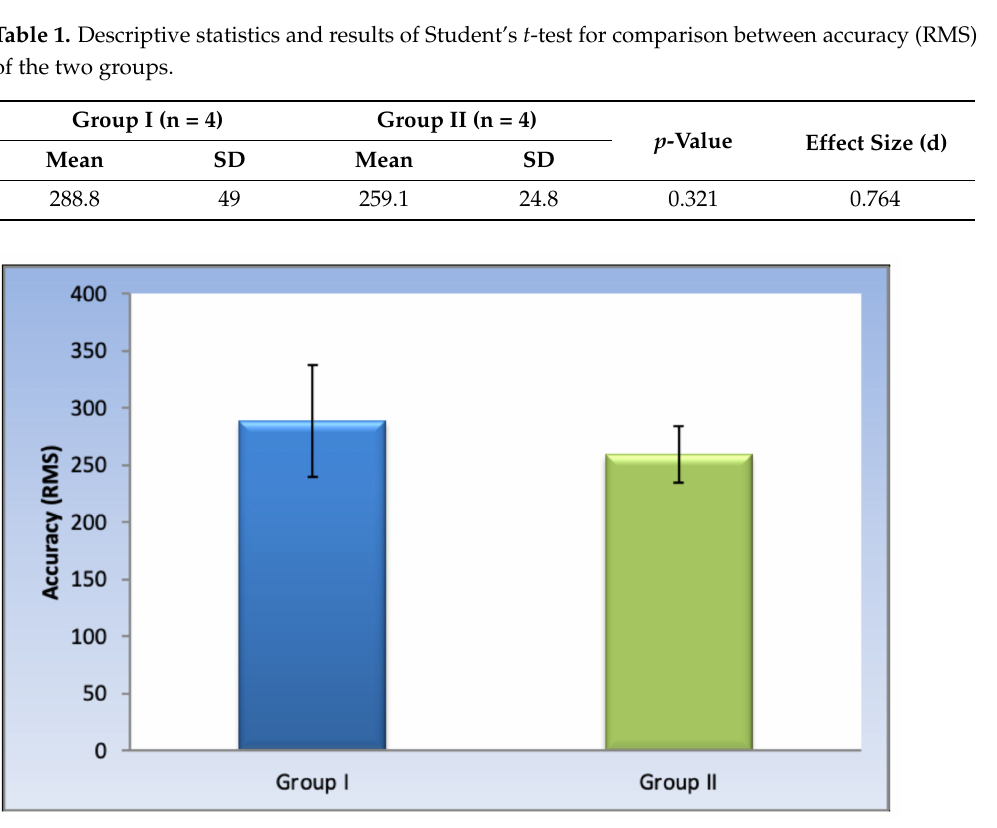
Figure 12. Bar chart representing mean and standard deviation values for the accuracy of the two